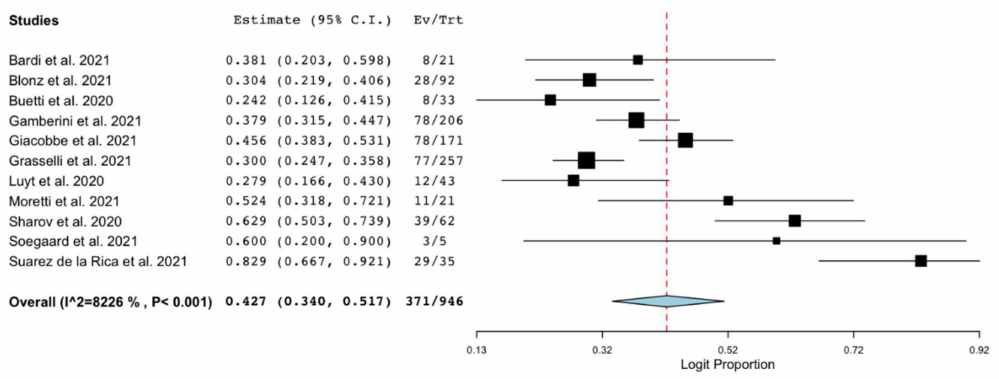
Figure 3. Forest plot with the result of single-arm meta-analysis for mortality of patients with COVID-19 and VAP. C.I., confidence interval; Ev, events; Trt,